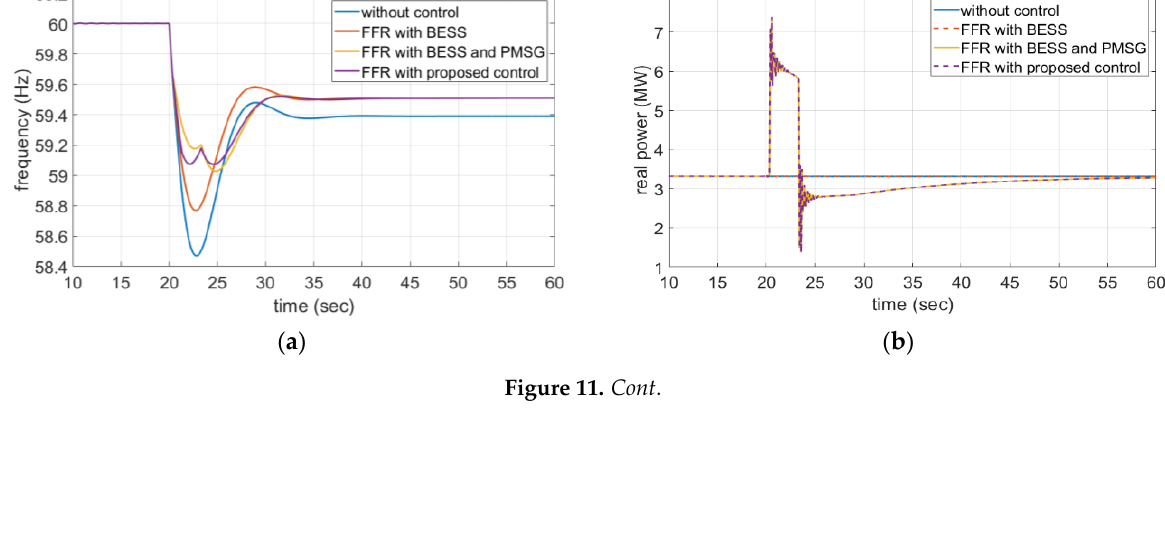
( d ) ( d ) Figure 11. Simulation results: ( a ) system frequency; ( b ) output power of the PMSG type wind turbine; ( c ) output power of synchronous generator #1; ( d ) output power of the BESS.